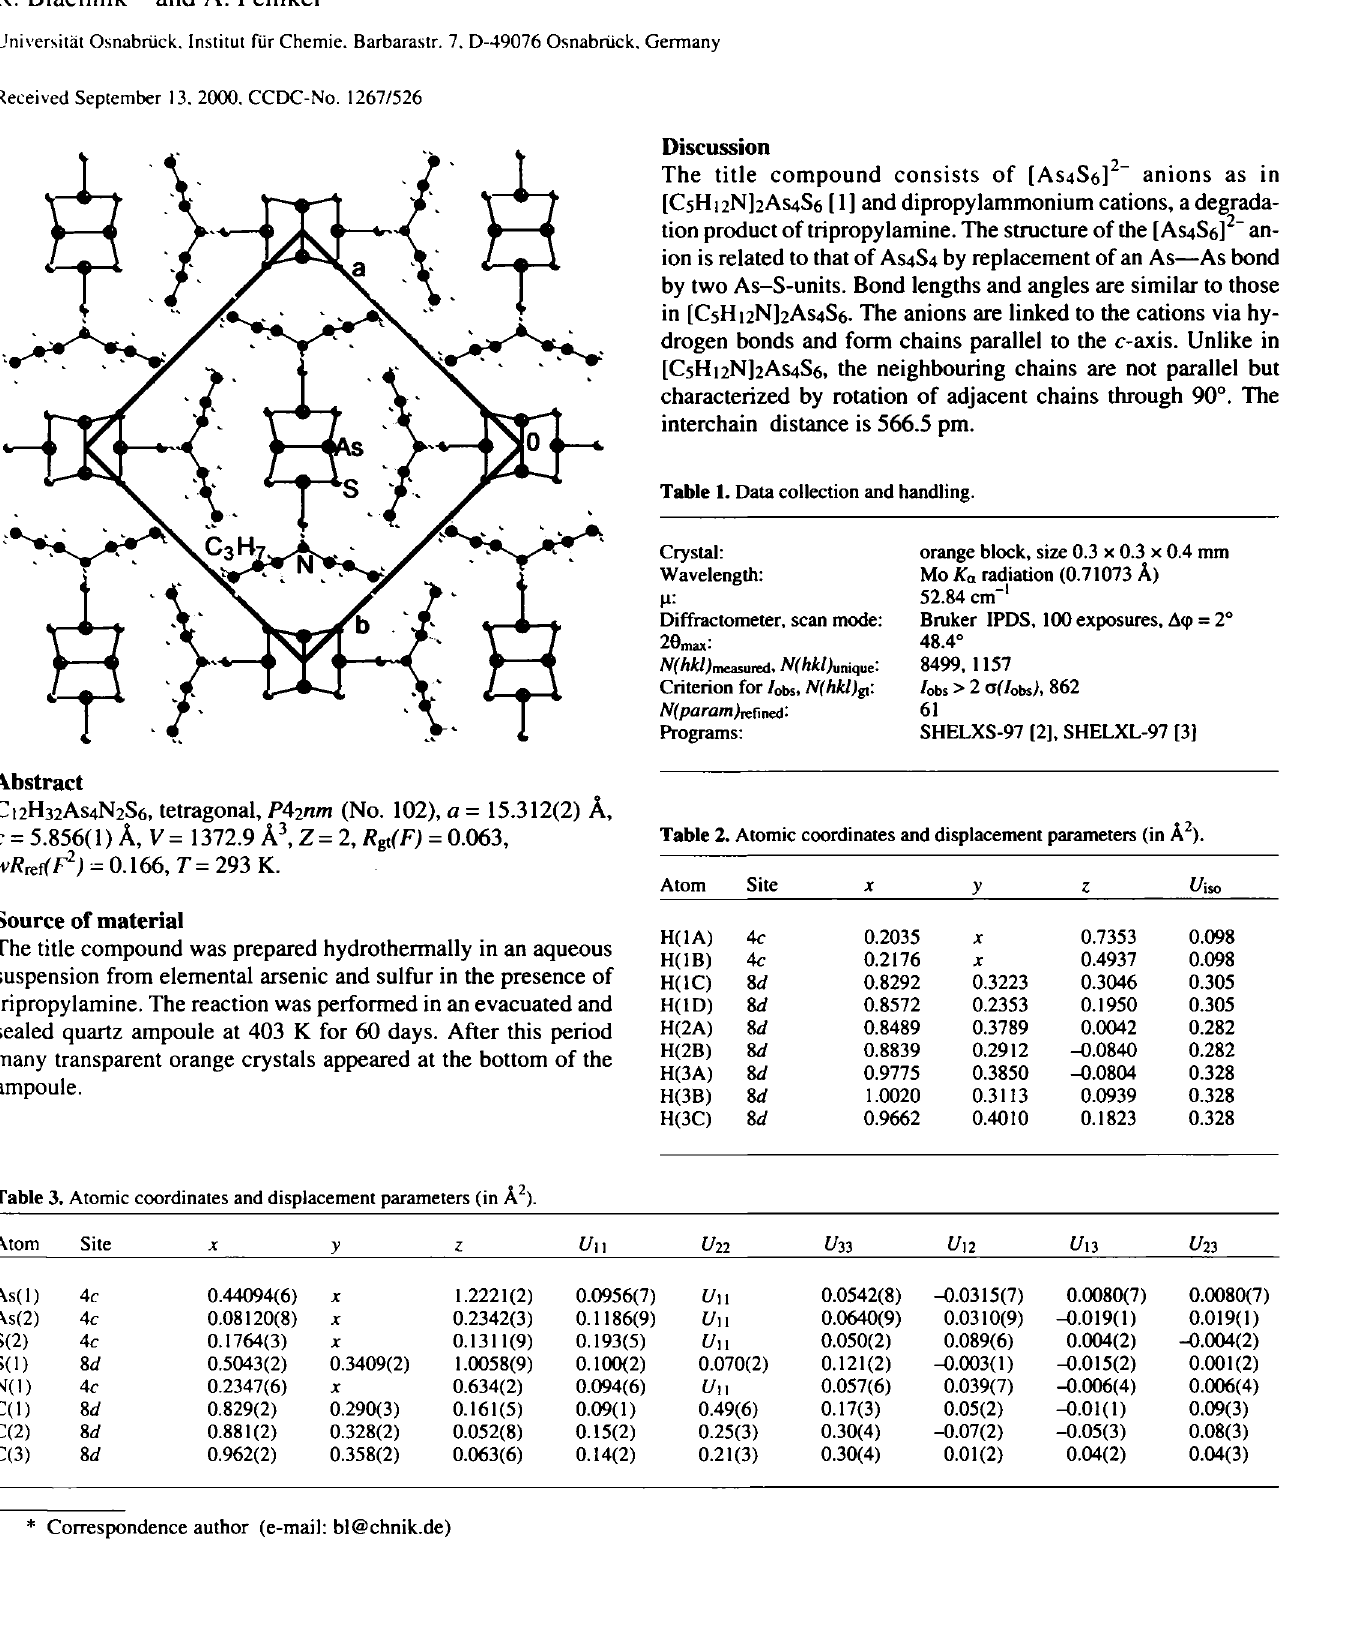
Table 1. Data collection and handling.